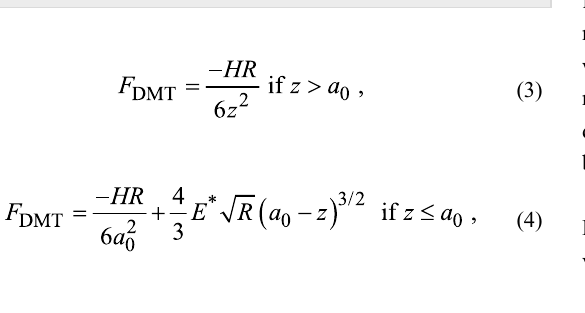
Figure 4: (a) and (b) show force trajectories for a tip under a numeri- cally simulated (not prescribed) single tapping mode trajectory for a DMT-García sample and a DMT-Gotsmann sample, respectively. The figures show the individual contribution of the conservative and dissi- pative forces, along with the total force. The insets show the behavior of the force contributions over time and reflect the symmetry aspects discussed in the main text. The simulation parameters for the cantilever dynamics in (a) and (b) are: cantilever position z c = 80 nm, natural frequency ( f 0 ) = 50 kHz, free amplitude ( A 01 ) = 50 nm, cantilever stiffness ( k m1 ) = 10 N/m. The model parameters for (b) and (c) associated with the DMT contribution are: elastic sample modulus ( E s ) of 3 GPa, elastic tip modulus ( E t ) of 150 GPa, Poisson’s ratio of tip and sample ( υ t and υ s , respectively) of 0.3, tip radius of curvature ( R ) of 10 nm, Hamaker constant of 2 × 10 − 19 J. For (a) a viscosity ( η ) value of 400 N·s/m 2 was used. For (b) a dissipation coefficient ( γ 0 ) of 3 × 10 − 7 kg/s, and a characteristic dissipation length ( z 0 ) of 0.75 nm were used. The blue and red arrows correspond to approach and retraction of the tip,